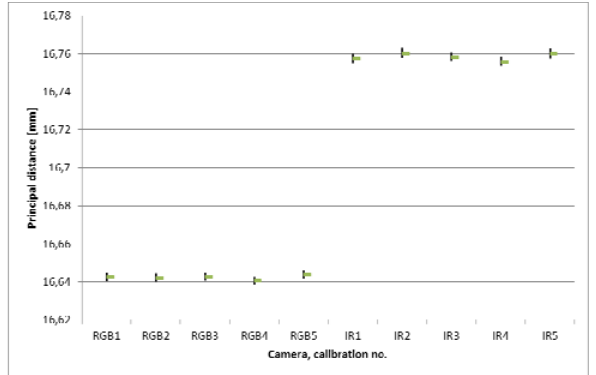
Figure 6. Calibration results for principal distance with the confidence interval (2 σ, 95% ) as black